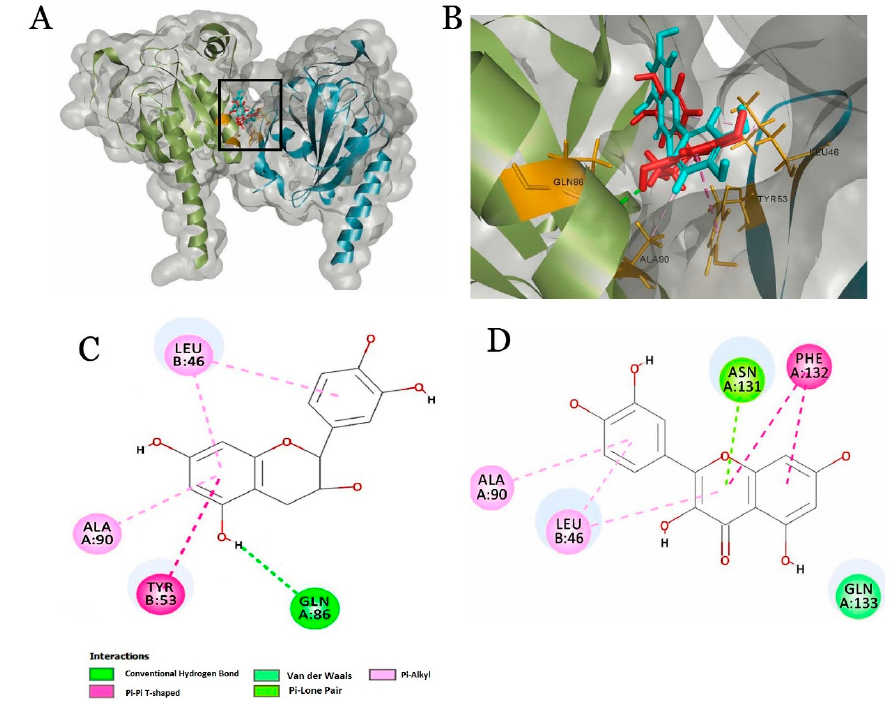
Figure 3. Interaction analysis with glutathione peroxidase 3 (GPX3) protein. ( A ) The black box represents the binding pocket of the tetrameric protein. ( B ) Expanded view shows ligand interaction with the amino acids in the binding pocket; 2D plot representing the amino acid interaction with epicatechin ( C ) and quercetin ( D ).